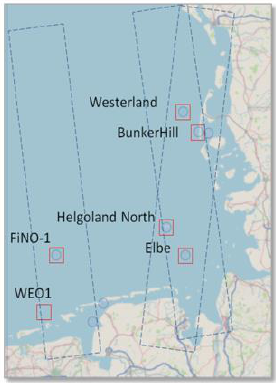
Figure 5. Concept for TerraSAR-X scenes ordering for CWAM wave model validations: two typical ascending and descending overflights collocated with 6 available buoys in the German Bight in wave model domain. Each acquired scene consists of 3-6 single images.